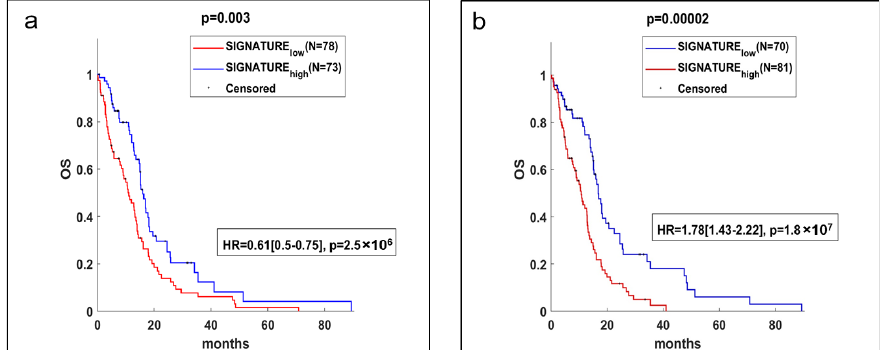
Figure 5. Prognostic gene signatures from DOWN (panel ( a )) and UP (panel ( b )) enriched pathways evaluated on TCGA GBM. The gene signatures were obtained considering all prognostic genes in- cluded in the positive- or negative-enriched pathways. Patients were split in low and high expression of the signature based on the negative or positive z-score of the mean genes expression, respectively. N = 151.